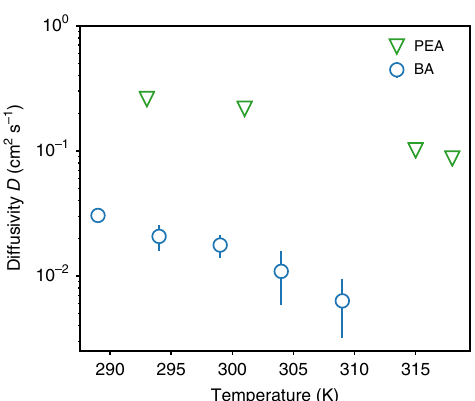
Fig. 4 Temperature-dependent diffusivity in (PEA) 2 PbI 4 (triangles) and (BA) 2 PbI 4 (circles). Error bars represent the uncertainty of the fi t and are smaller than the markers for (PEA) 2 PbI 4